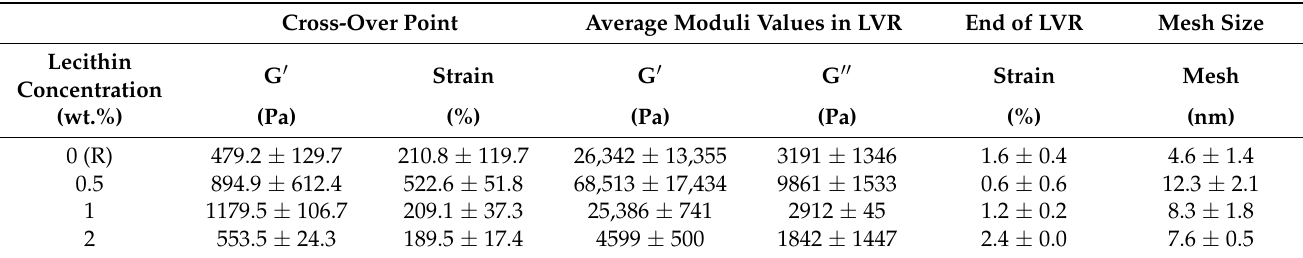
Table 5. Values for ionically crosslinked alginate hydrogels after drying and rehydration obtained from the strain and frequency sweep